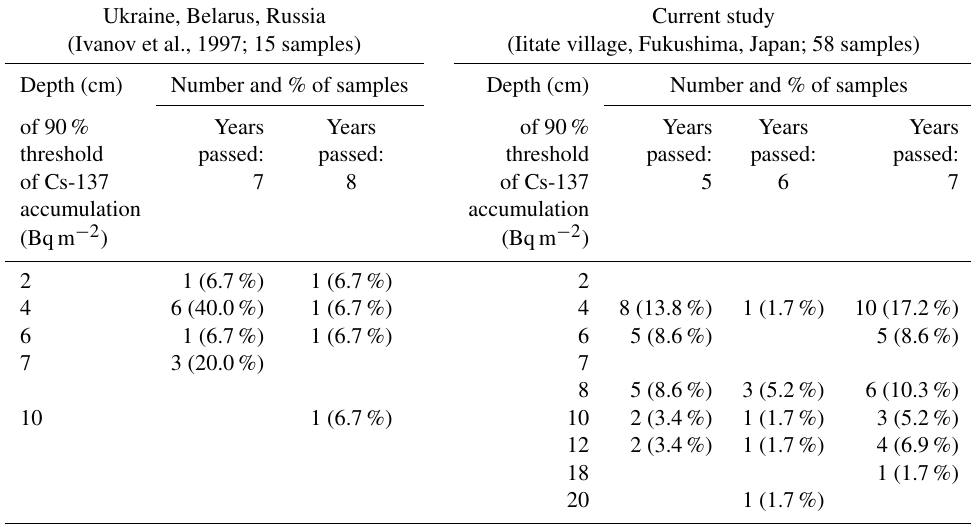
Table 7. Comparison of Cs-137 downward migration depth between the CNPP accident-affected area and Fukushima at about the same length of time after the nuclear plant accidents. Values in the current study are not decay